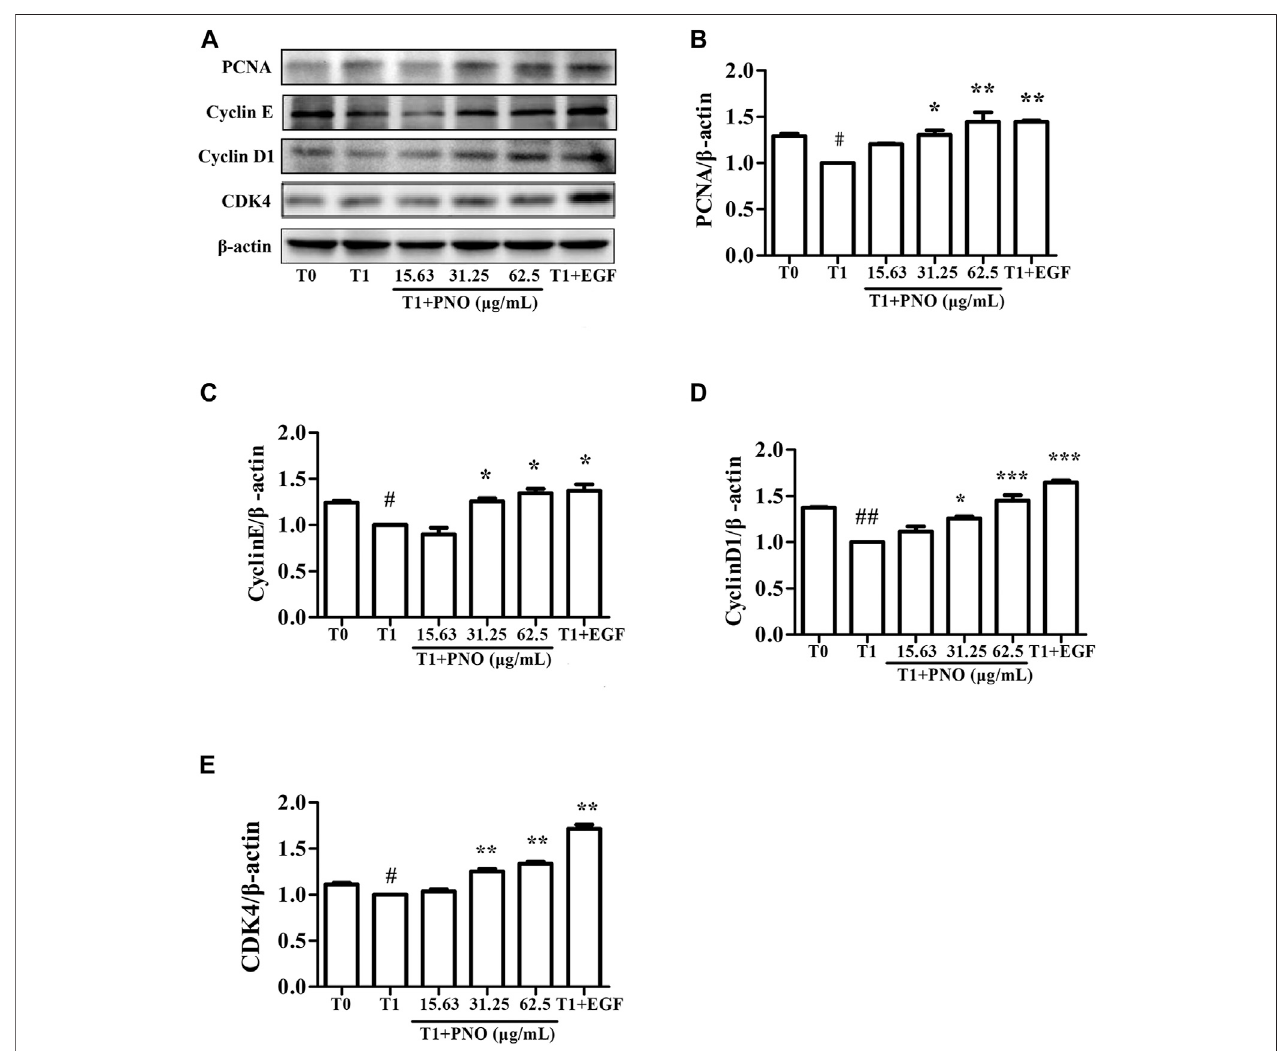
FIGURE 5 | Effect of PNO on expression of cycle-related proteins in replicative senescent NIH-3T3 cells. (A) Western blotting analysis of expression of cycle-related proteins. (B – E) Quanti fi cation of bands relative to GAPDH using Image J software. All data are presented as the mean ± SD of at least three independent experiments. # indicatesasigni fi cantdifferentrelativetoT0group. # p < 0.05, ## p < 0.01, ### p < 0.001.*Indicatesasigni fi cantdifferentrelativetoT1group.* p < 0.05,** p < 0.01,*** p < 0.001.